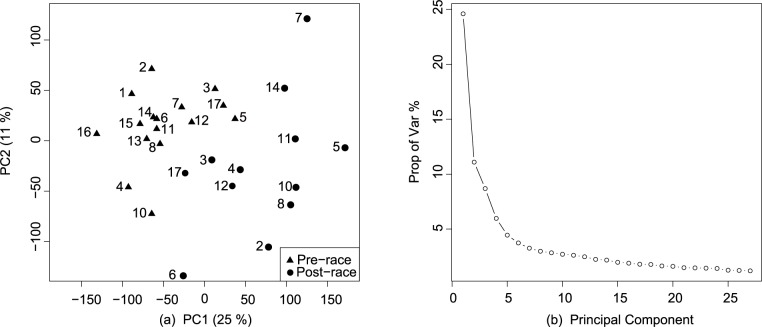
Principal component analysis (PCA) over the expression values of the ranked transcript clusters (TCs).(a) PCA over 25,272 TCs expression values targeting protein coding RNA molecules included in HuGene20st microarray. First principal component was aligned with the effect of participating in the Ultra Marathon Trail (UMT) (b) Proportion (in %) of captured variance per principal component.